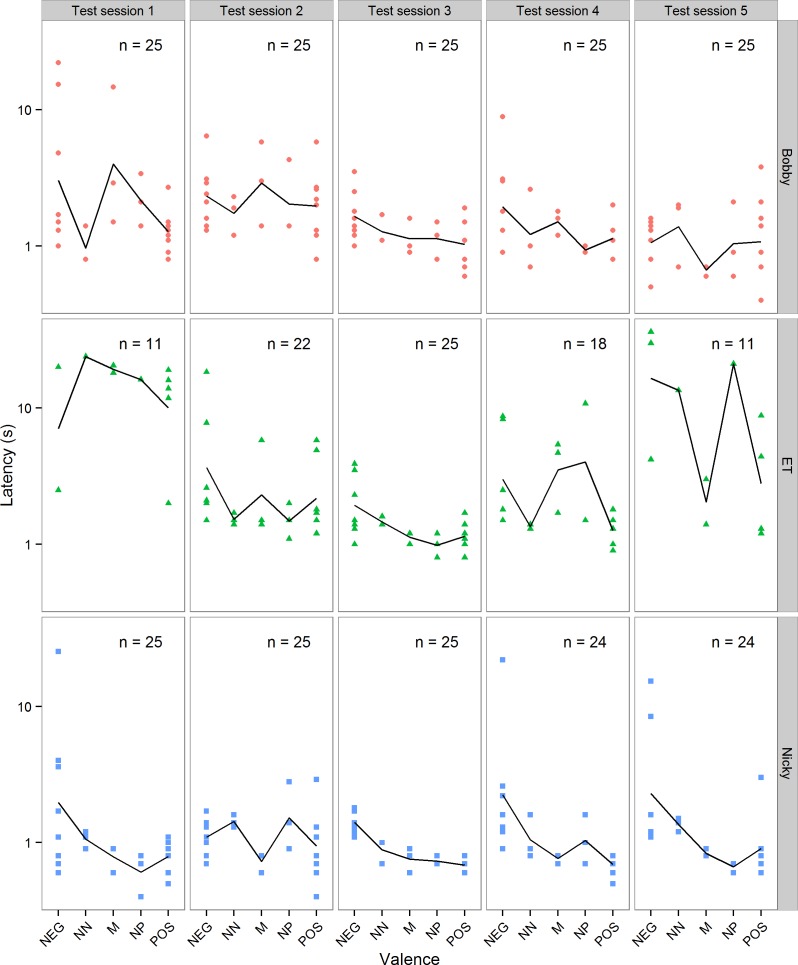
Test data.Individual latencies to touch cones of each valence in each of the five test sessions for each of the three chimpanzees. Note that latency is plotted on a log axis to aid display of the data. The solid line in each panel shows the mean latencies for that test session. The number of trials (n) out of a maximum of 25 in each session in which the chimpanzee touched the cone within 60 s is given in each panel.